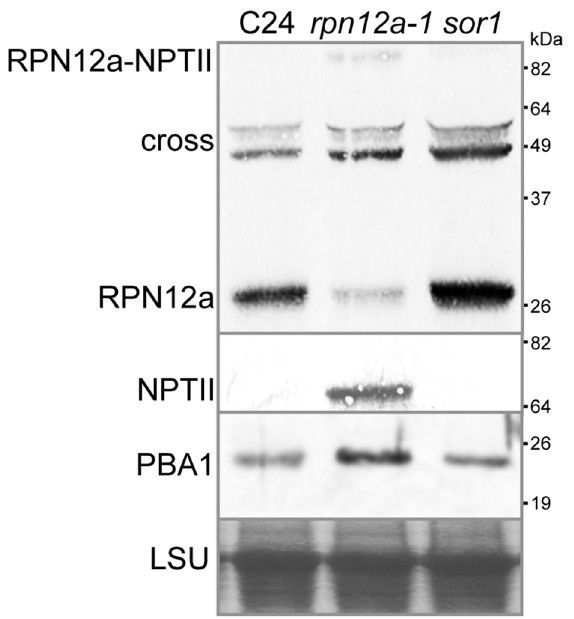
Figure 4. The RPN12a‑NPTII fusion protein is absent in the sor1 mutant. Total protein was isolated from two-week-old wild-type (C24), rpn12a‑1 and sor1 seedlings and used for immunoblotting analyses with RPN12, NPT and PBA1 antisera. In addition to the RPN12a and RPN12a-NPTII fusion proteins, the anti-RPN12 sera also recognized two proteins (cross) that are not related to RPN12a. Ponceau S-stained membrane showing the large RuBisCO subunit (LSU) is presented as a loading control. The size of the proteins used as molecular mass standards is shown on the right-hand side.